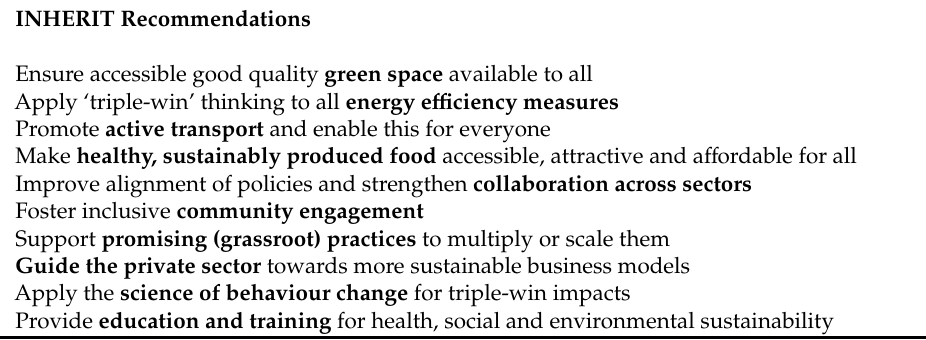
Table 1. INHERIT Policy Toolkit